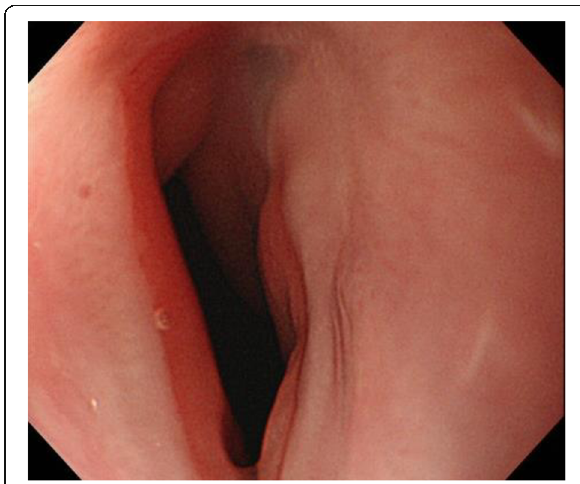
Fig. 4 Although the patient required balloon dilatation for esophageal stenosis that developed during the healing process, the